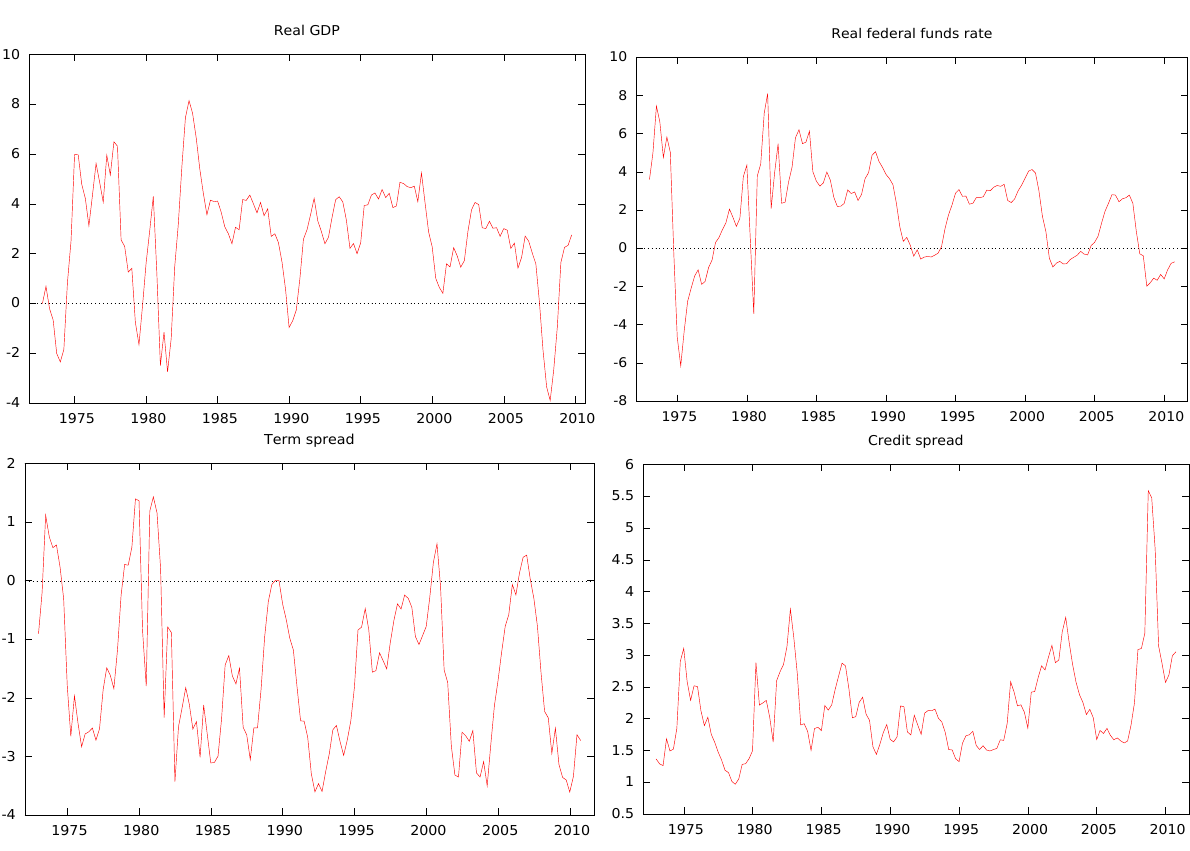
Figure 1. Raw series: Quarterly aggregate data from 1973:1 to 2009:4.